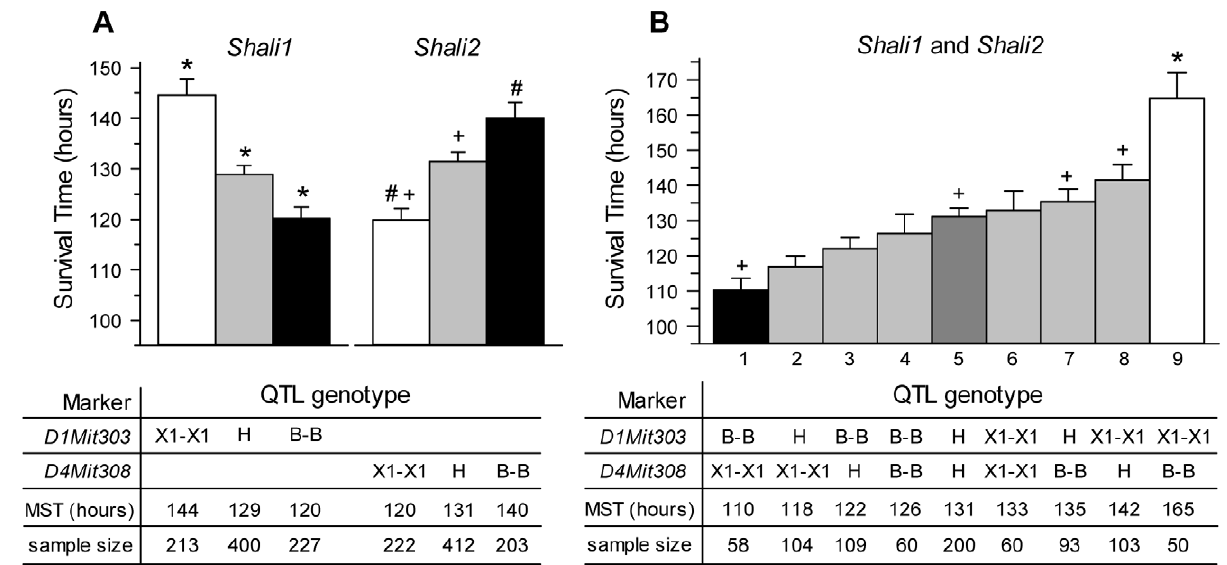
Figure 1. Mean survival times of mice grouped by genotypes at markers with peak LOD scores for Shali1 and Shali2 . The F 2 population (n=840) generated from sensitive B and resistant X1 mice [25] was sorted into groups based on their genotypes (X1-X1, H, or B-B) at the peak MIT marker representing Shali1 ( D1Mit303 ; 1–303) or Shali2 ( D4Mit308 ; 4–308) (panel A) or at both peak markers (panel B). Survival times of mice for each genotype group was determined and plotted as the mean (MST) 6 SEM. Groups that differed from each other are marked with the same symbol. Panel A shows a near mirror image of the genotype bar plots, indicative of the reciprocal allelic effects of Shali1 and Shali2 . For Shali1 ( D1Mit303 ), F 2 mice for all three genotype groups differed from each other (indicated by *). For Shali2 ( D4Mit308 ), F 2 mice homozygous for X1 alleles differed from mice H or B-B ( + ), and mice B-B differed from those X1-X1 ( # ). Panel B shows a gradation of effect for the 9 different pairwise genotypes, with the polar extremes for MSTs ( i.e. , bars 1 vs. 9) occurring with the B-B, X1-X1 (high sensitivity) and X1-X1, B-B (high resistance) reciprocal genotypes at Shali1 and Shali2 , respectively. Moving inward from each end gives group comparisons for each reciprocal genotype pair ( i.e. , bars 2 vs. 8, bars 3 vs. 7 and bars 4 vs. 6). The group of mice heterozygous for both markers fell in the center (bar 5), with a MST intermediate to all other groups. n, represents the number of F 2 mice successfully genotyped for each (or both) MIT marker(s). F 2 mice with genotype 9 ( i.e. , X1-X1, B-B at D1Mit303 and D4Mit308 , respectively) were the most resistant and differed from all other genotypes (indicated by *). F 2 mice with the reciprocal B-B, X1-X1 genotype were the most sensitive and, besides differing from genotype 9, also differed from genotypes 5, 7, and 8 ( + ). congenics (Figure 3). The B.X1 and X1.B reciprocal consomic